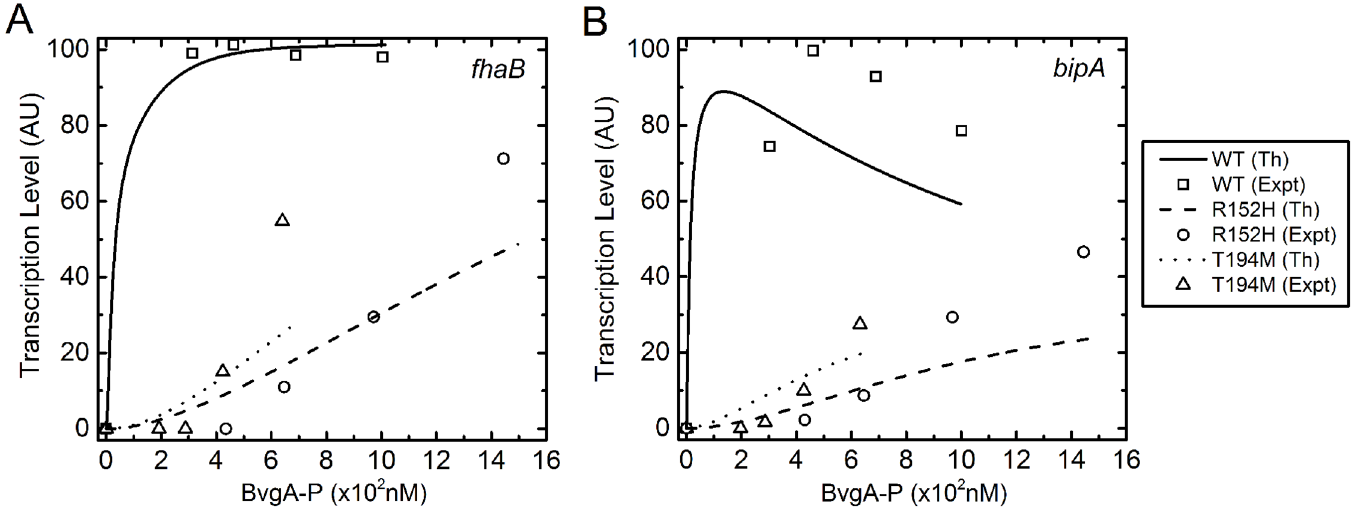
Fig 5. In vitro transcription assay. Profiles of in vitro transcription assay generated using stochastic optimization for A . fhaB and B . bipA . The solid, dashed and dotted lines are for WT, R152H and T194M, respectively. The symbols are experimental results due to Jones el al. [24]. In the figure legend Th and Expt stand for theoretical and experimental data,